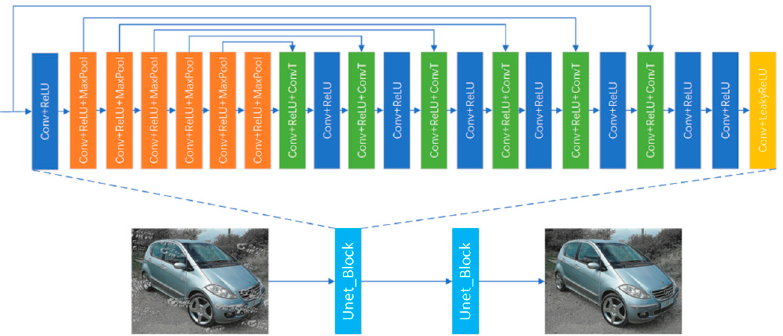
Figure 1. Network architecture of IWRU-net.